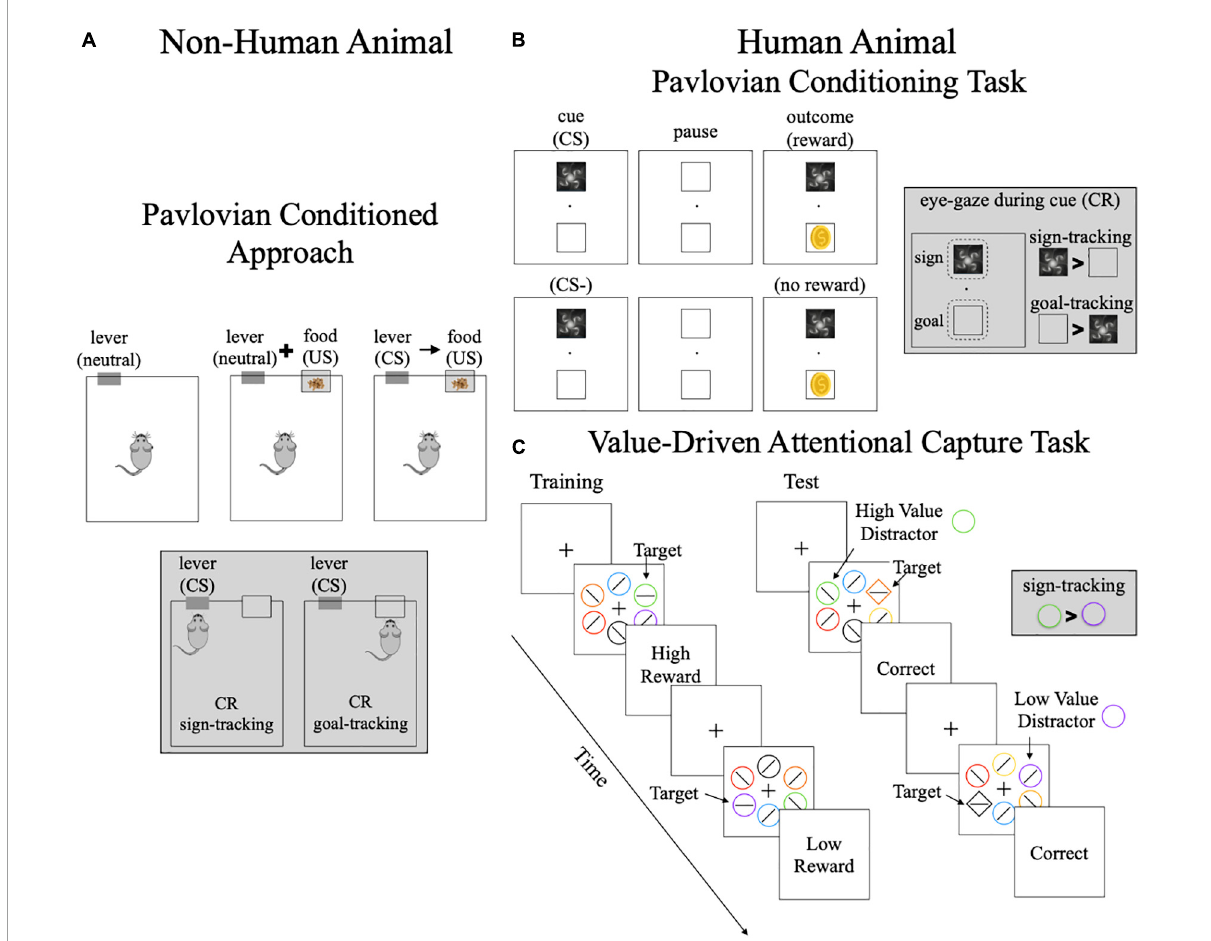
FIGURE1 Methods of assessing sign-and goal-tracking phenotypes. (A) Pavlovian conditioned approach task–this task is used in non-human animal models. Animals learn the stimulus-outcome (S–O) association between the lever and food delivery. The conditioned responses are: (1) sign-trackers–approach the lever; (2) goal-trackers–approach the location of food delivery. (B) Pavlovian conditioning task–this is a simplified schematic of a Pavlovian conditioning task where a conditioned stimulus either predicts reward receipt or no reward. The conditioned stimulus and reward are presented in different locations so the conditioned response of eye-gaze can be measured. The conditioned responses are: (1) sign-trackers–look at the conditioned stimulus more than reward location; (2) goal-trackers–look more at the reward location than conditioned response. (C) Value-Driven Attentional Capture Task–this task includes a training and a test phase. Both phases include a visual search task where participants must locate the location of the horizontal line. During training, one color is associated with high reward (e.g., green) and one color is associated with low reward (e.g., purple). During the test phase, the target is the unique shape and the previously rewarded colors are used as high or low value distractors. No reward is given for correct responses in the test phase. The conditioned responses are: (1) sign-trackers–looking at the previously rewarded cue, resulting in slower reaction times; (2) goal-trackers–not distracted by previously rewarded cues. CS, conditioned stimuli; CR, conditioned response; US, unconditioned stimuli. Gray boxes highlight the definition of sign-and goal-tracking for each